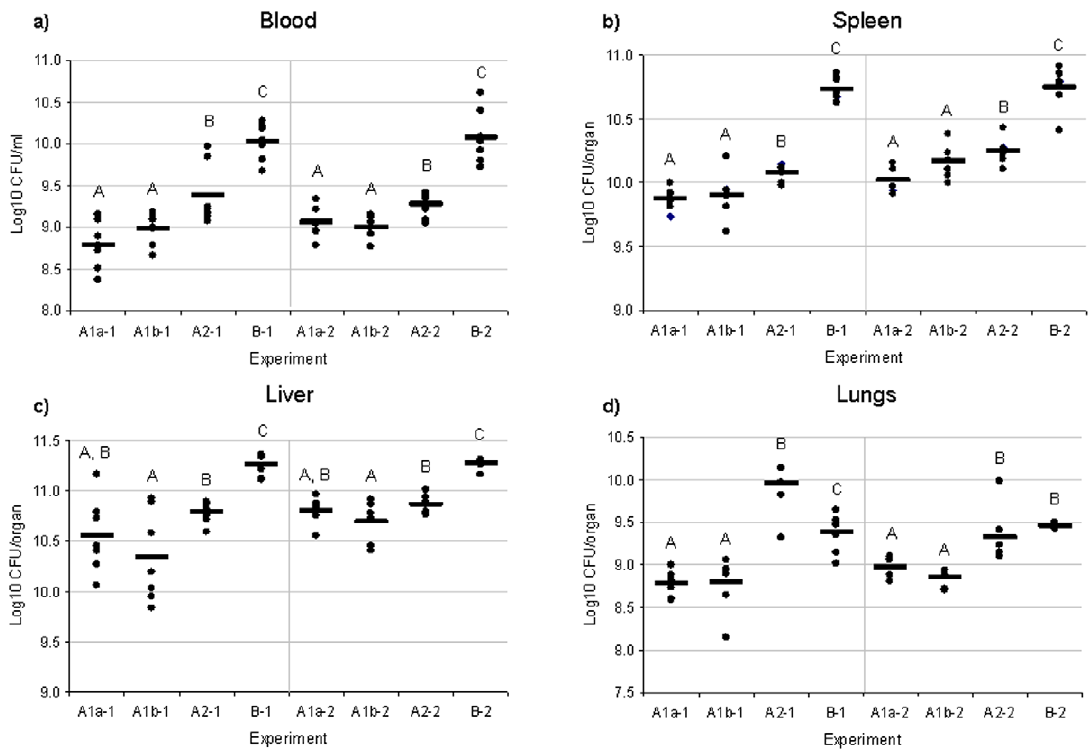
Figure 3. Bacterial burden of F.tularensis within the blood, spleen, liver and lungs of infected mice. C57BL/6J mice (n=14/group) were challenged intradermally with 10-20 CFU of F. tularensis A1a, A1b, A2, and type B. At time of death, organs were harvested and blood was taken from each mouse. A ) Bacterial burden (Log 10 CFU/ml) within blood samples of all infection groups. No statistical difference was observed between round 1 and round 2. B ) Bacterial burden (Log 10 CFU/spleen) within spleens of all infection groups. A statistical difference was observed between round 1 and round 2. C ) Bacterial burden (Log 10 CFU/liver) within livers of all infection groups. No statistical difference was observed between round 1 and round 2. D ) Bacterial burden (Log 10 CFU/lung) within lungs of all infection groups. A statistical difference was observed between round 1 and round 2. For all graphs, significant differences (p , 0.05) in Log 10 CFU within round 1 infections and within round 2 infections are shown by different letters (A, B, etc.). If two strains have the same letter, no significant differences were identified between